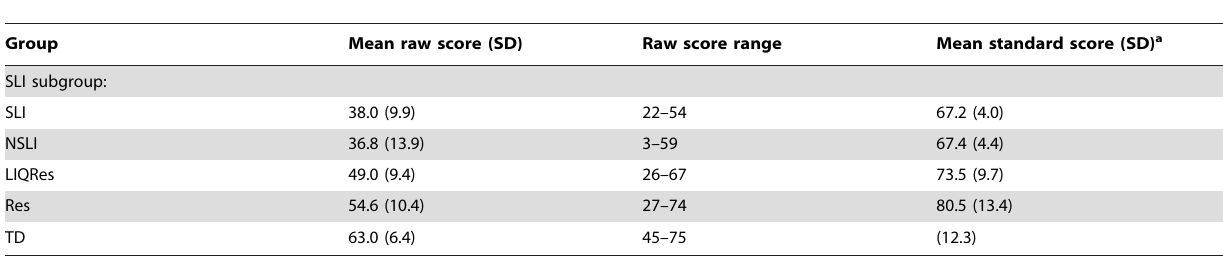
Table 3. Recalling sentences scores for subgroups of children with a history of SLI and TD children.